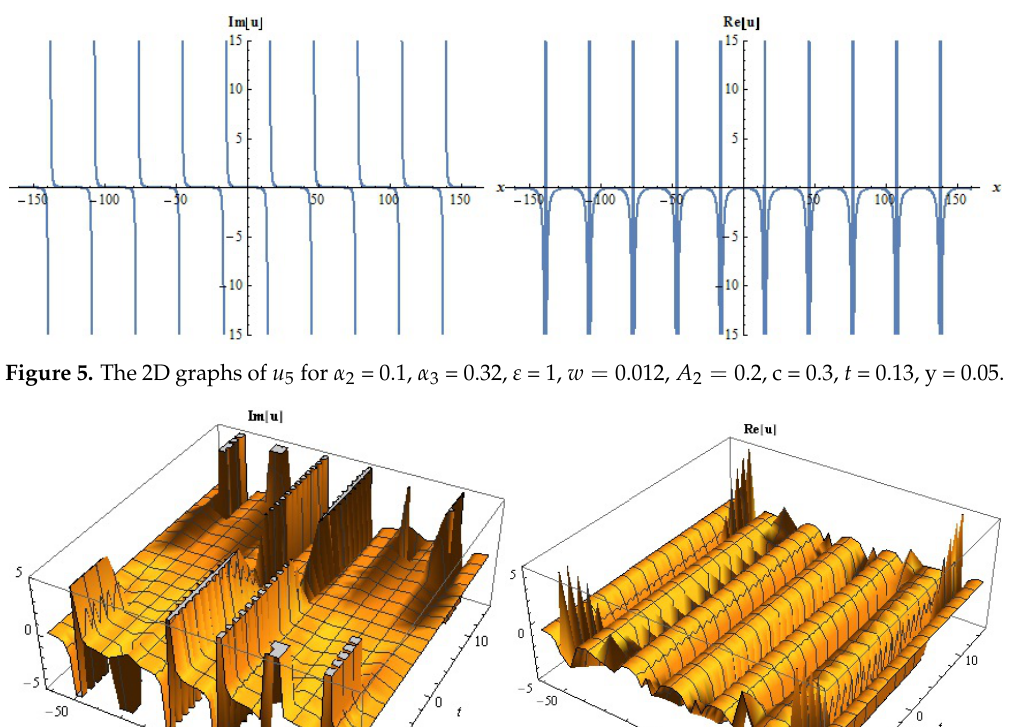
Figure 4. The contour simulations of u 5 for α 2 = 0.1, α 3 = 0.32, ε = 1, w = 0.012, A 2 = 0.2, c = 0.3, y = 0.05.